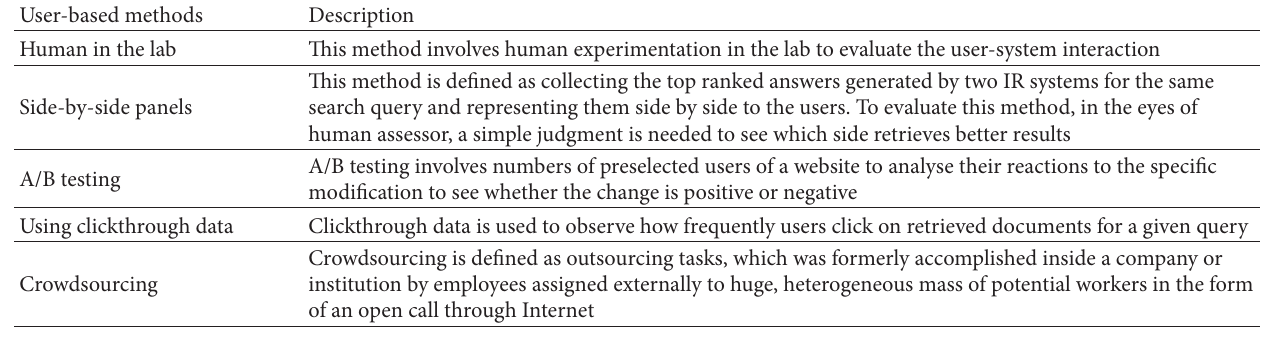
Table 1: User-based evaluation methods.